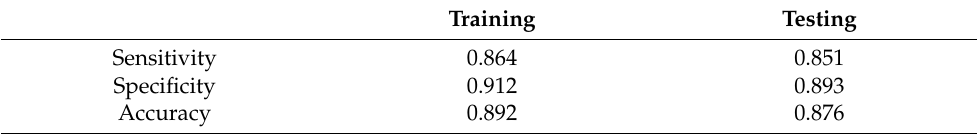
Table 4. Values of statistical measures.